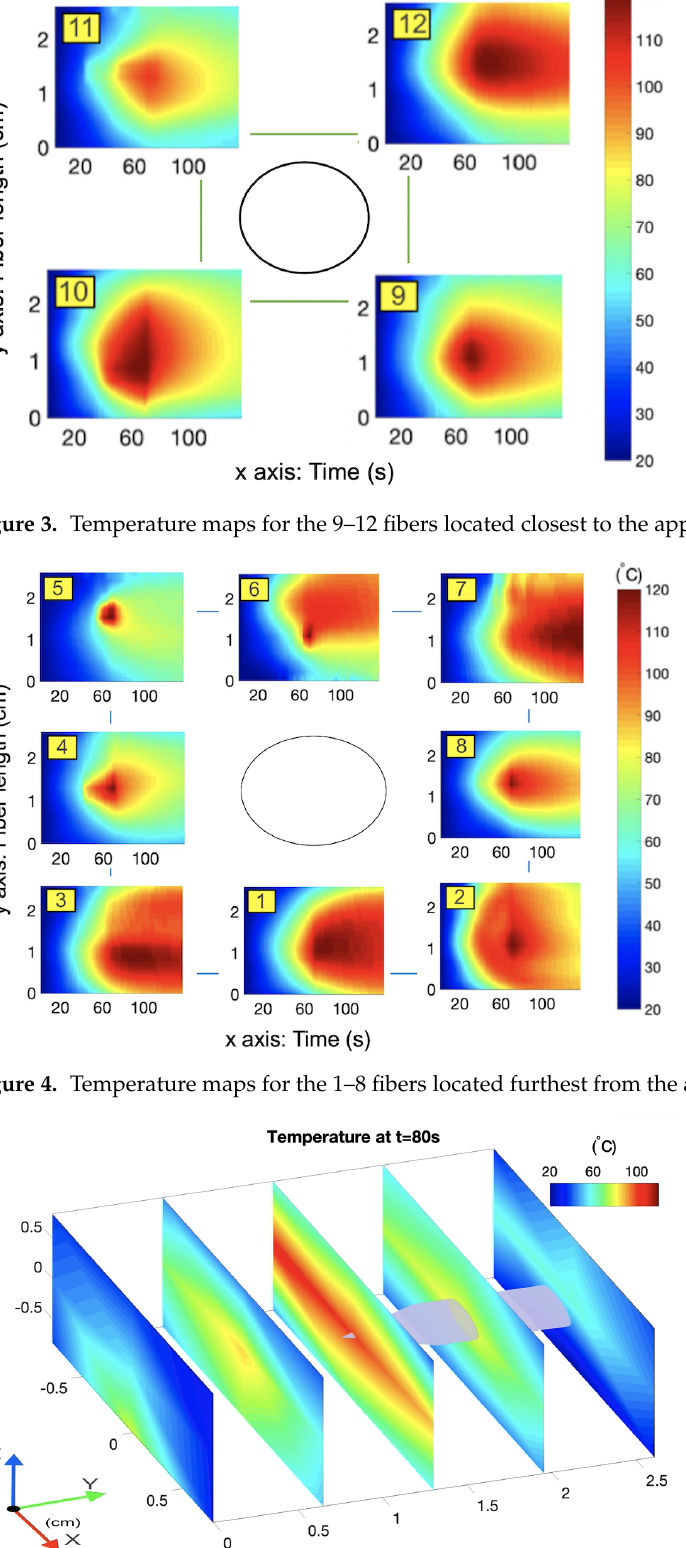
Figure 5. 3D temperature profile of the scaffold during MW ablation (y-axis: parallel to the sensing MgO-doped fiber length and direction of the applicator, x and z-axes: horizontal and vertical directions of the fiber arrangement. (Video S1, MOV, 9.7